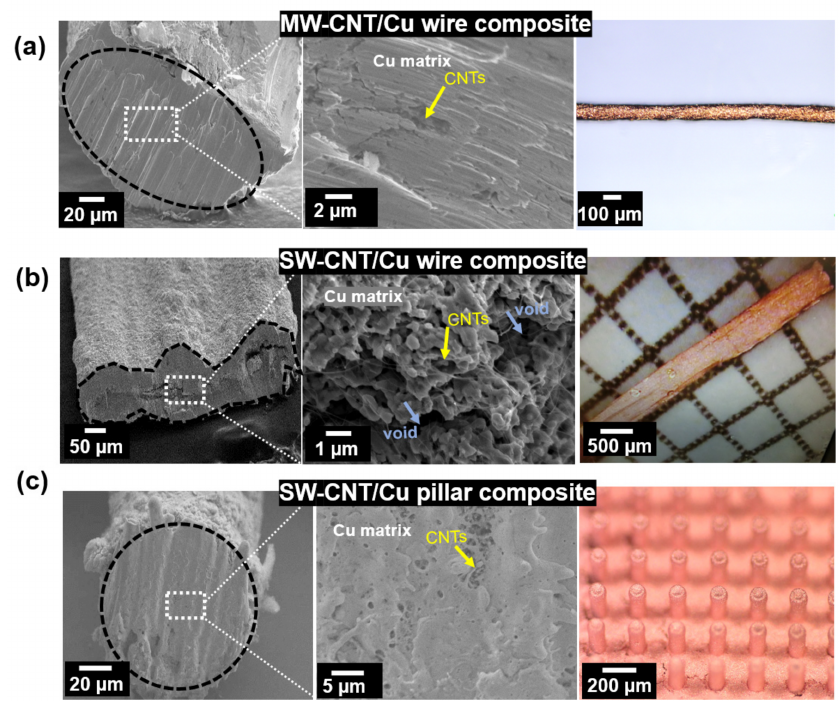
Figure 3. Low- and high-magnification CS-SEM images and optical micrographs of ( a ) MW-CNT/Cu